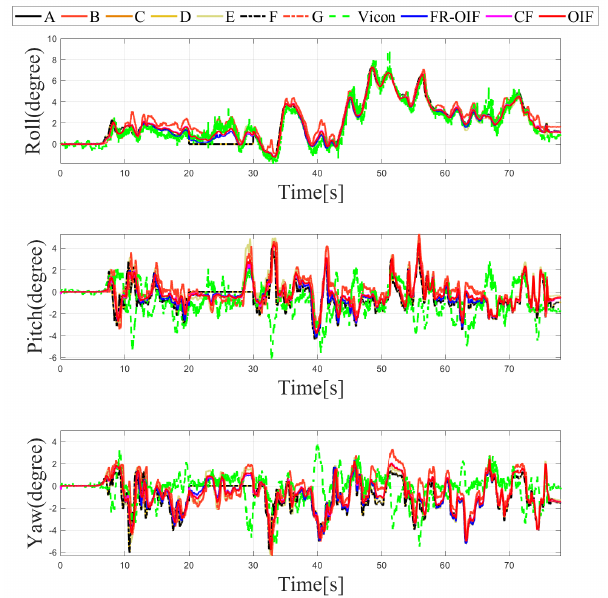
Figure 7. Variation of orientation represented using Euler angles obtained from intermediate nodes ( A , . . . , G ), CF, OIF, FR-OIF and the ground truth. During the experiment, the transnational motion is dominant over the rotational motion. As a result, the significant impact of FR-OIF is difficult to be